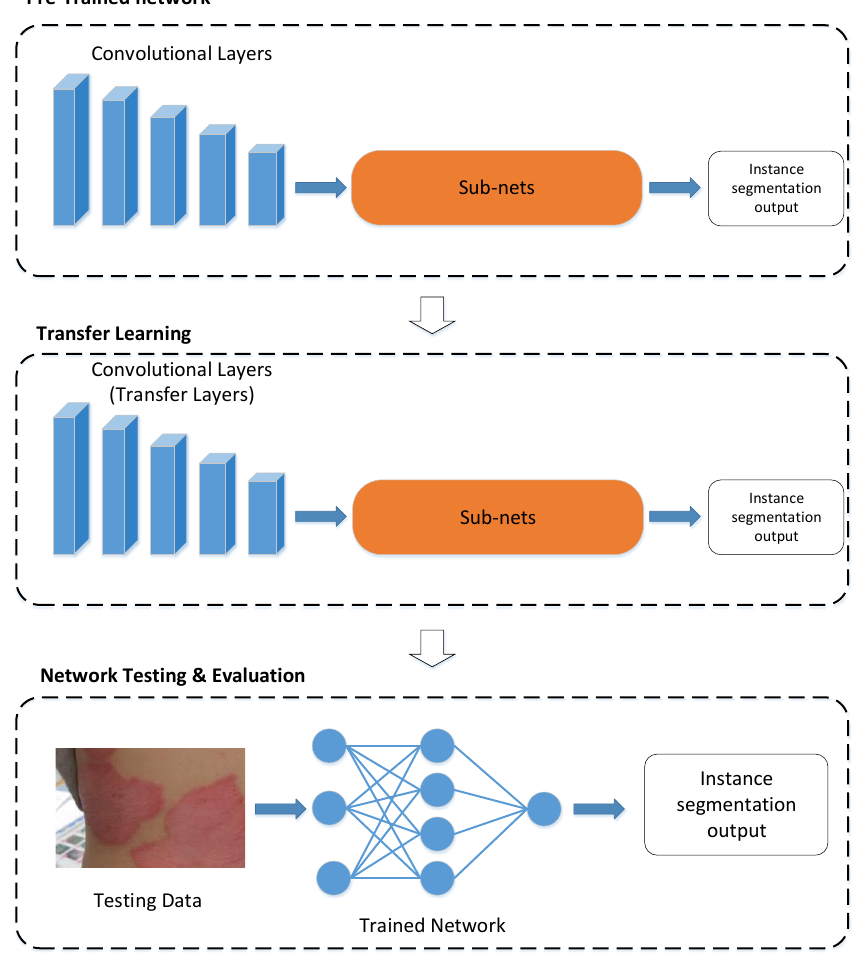
Figure 2. Methodological illustration of the proposed scheme.